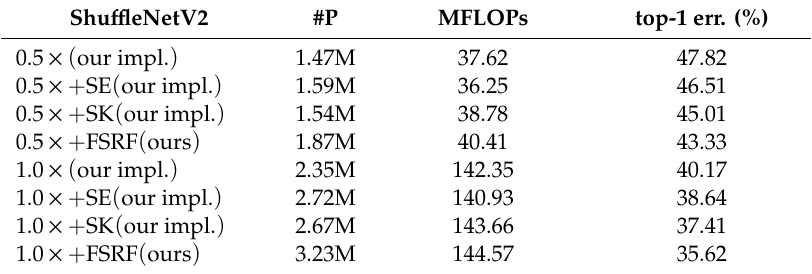
Table 3. Single 224 × 224 cropped top-1 error rates (%) on the Tiny ImageNet validation set and complexity comparisons, with all models based on the corresponding Shu ffl eNetV2.